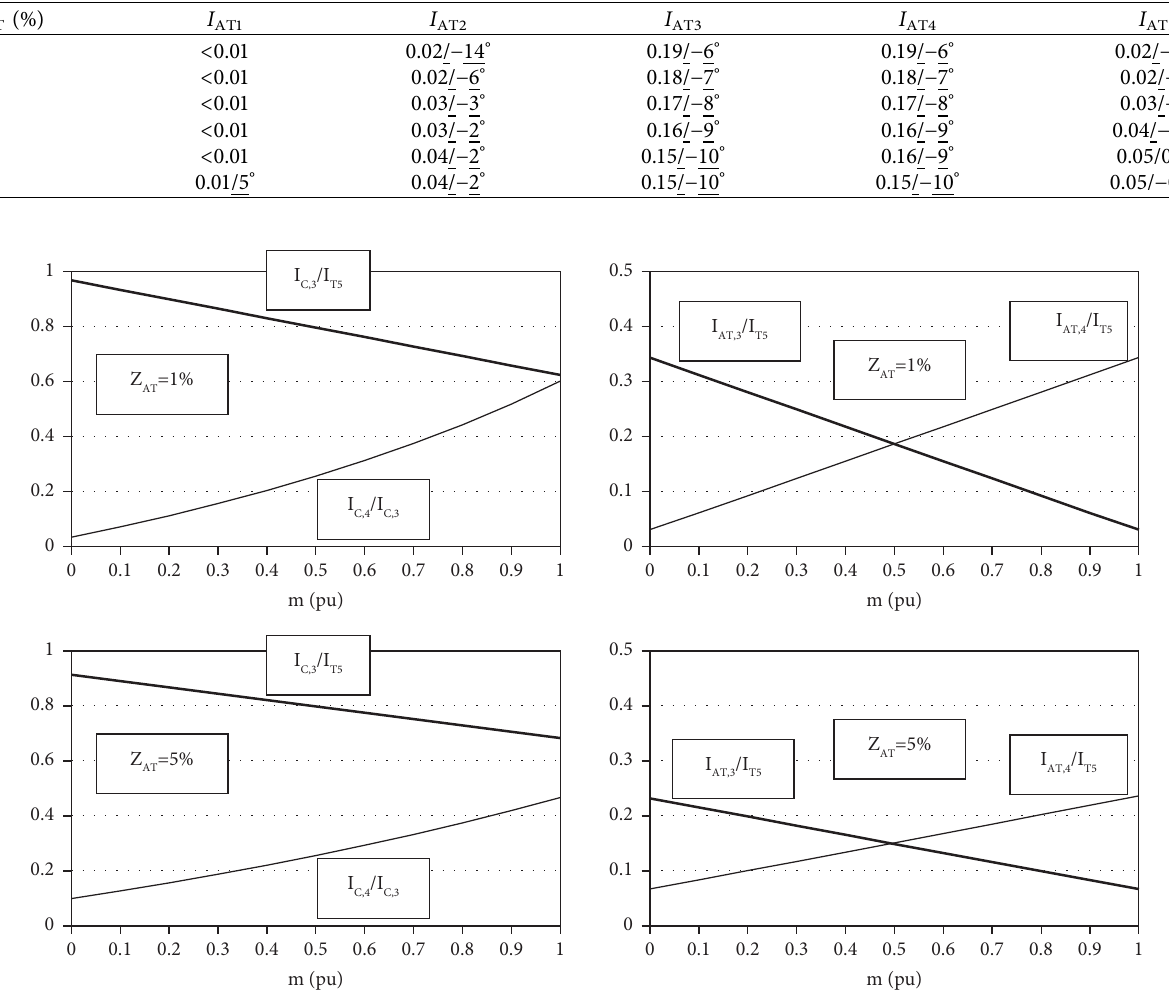
Figure 9: Main distributions of currents as a function of train position (m) for the example with only one train and real